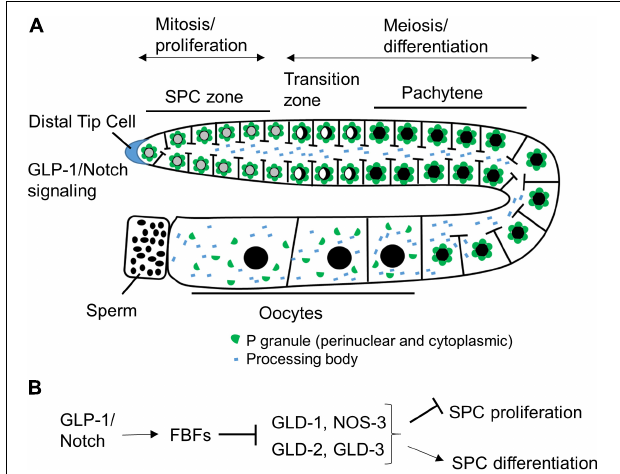
FIGURE 1 | Schematic of C. elegans hermaphrodite germline and RNA binding protein network downstream of GLP-1/Notch. (A) C. elegans germline development is supported by continuous SPC proliferation promoted by GLP-1/Notch signaling from the DTC (Pazdernik and Schedl, 2013). Progenitors enter meiosis when they reach the transition zone, and later differentiate into sperm and oocytes. Several types of RNA granules reside in germ cells and facilitate germ cell development and embryogenesis. (B) Downstream of GLP-1/Notch, FBFs maintain SPC proliferation by repressing the expression of GLD-1, GLD-2, and GLD-3 that inhibit SPC proliferation and promote differentiation (Kimble and Crittenden, 2007 and references in sections “RNA-Binding Protein Network Downstream of GLP-1/Notch” and “PUF Function in Maintaining Germline